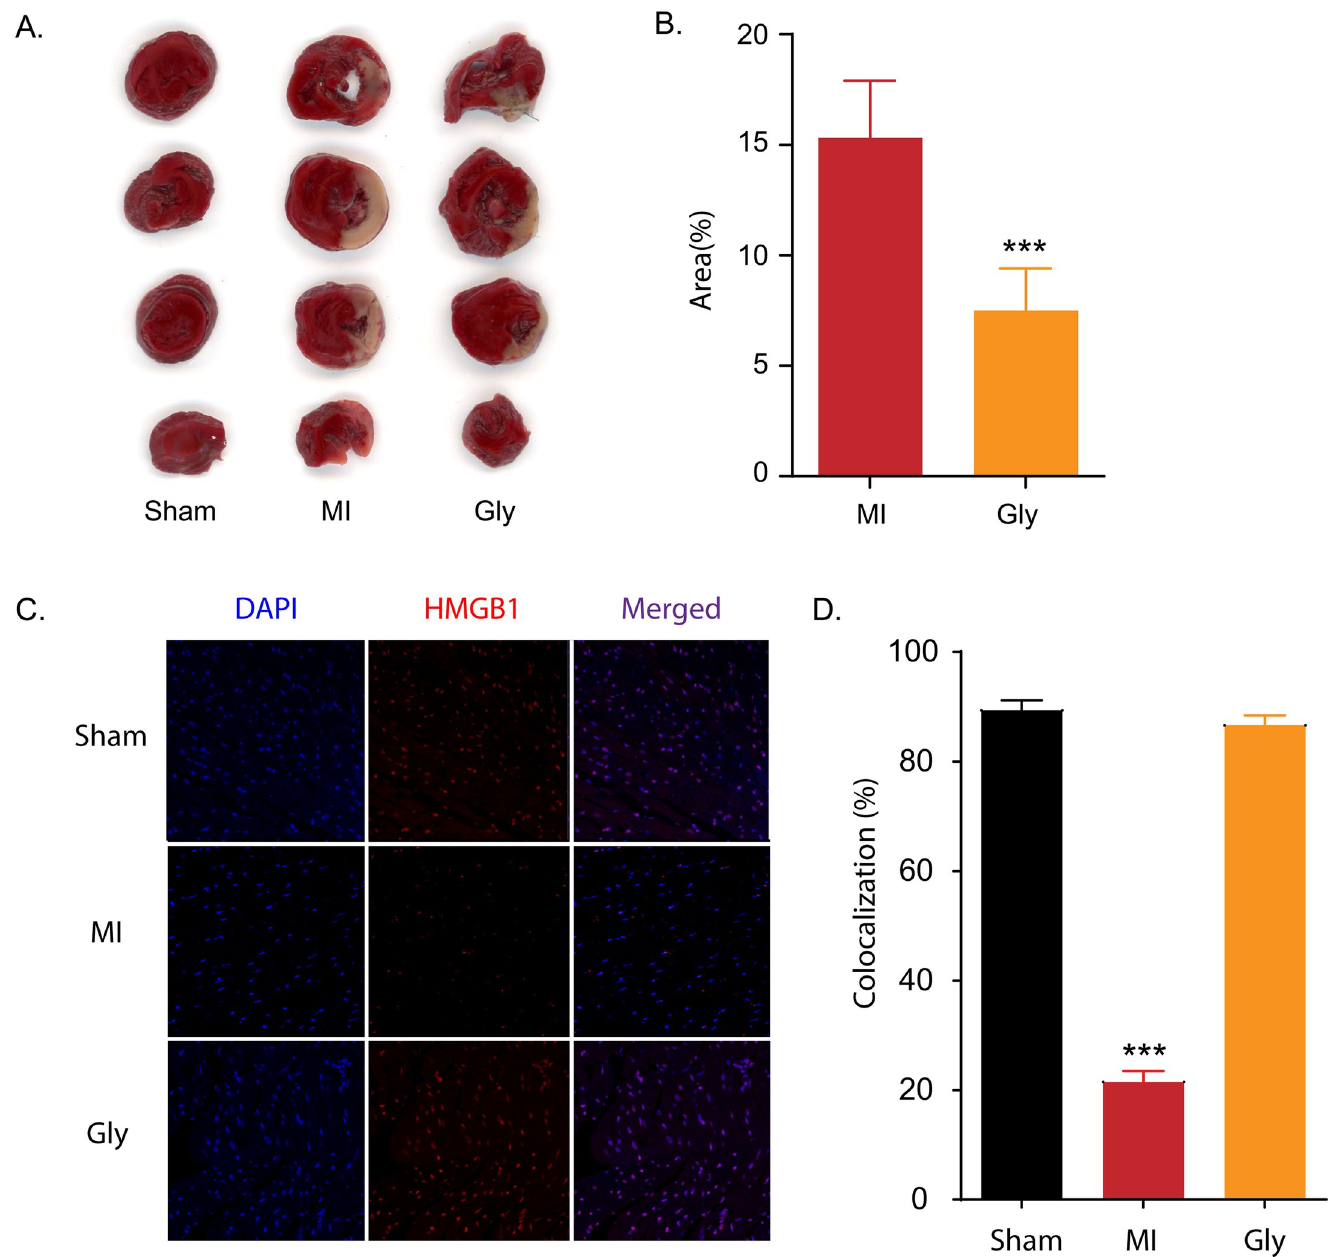
Fig 4. Glycyrrhizin reduces infarct volume in myocardial I/R injury and glycyrrhizin suppresses extracellular release of HMGB1 in myocardial I/R injury. To verify the cardioprotective effect of TTM by specifically inhibiting HMGB1, rats were assigned to sham, LAD I/R, and LAD I/R after pre-treatment with glycyrrhizin (known as a pharmacological inhibitor of HMGB1) groups. A. Representative image for 2,3,5-triphenyltetrazolium chloride (TTC) staining comparing myocardial I/R injury with normothermia and glycyrrhizin pre-treatment. B. Quantification of TTC staining results in A (the number of animals: n = 5, respectively). ��� P < 0.001 comparing myocardial I/R injury with and without glycyrrhizin, unpaired t -test. C. Quantification of immunohistochemistry results in D (the number of animals: n = 5, respectively). D. Representative images showing HMGB1 immunoreactivity from myocardial I/R injury with and without glycyrrhizin B treatment. ��� P < 0.001, comparing myocardial I/R injury with and without glycyrrhizin by one-way analysis of variance (ANOVA) followed by Bonferroni post hoc test.